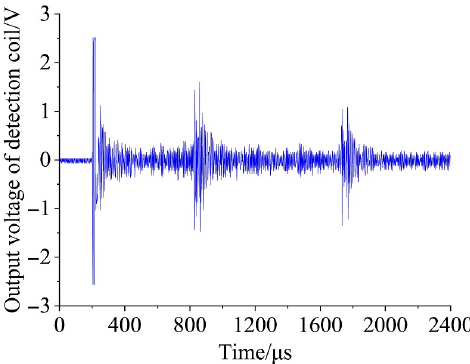
Figure 16. The e ff ective waveform graph acquired by the oscilloscope when adjacent magnetic fi eld Figure 16. The effective waveform graph acquired by the oscilloscope when adjacent magnetic field coils reach the minimum interval distance. coils reach the minimum interval